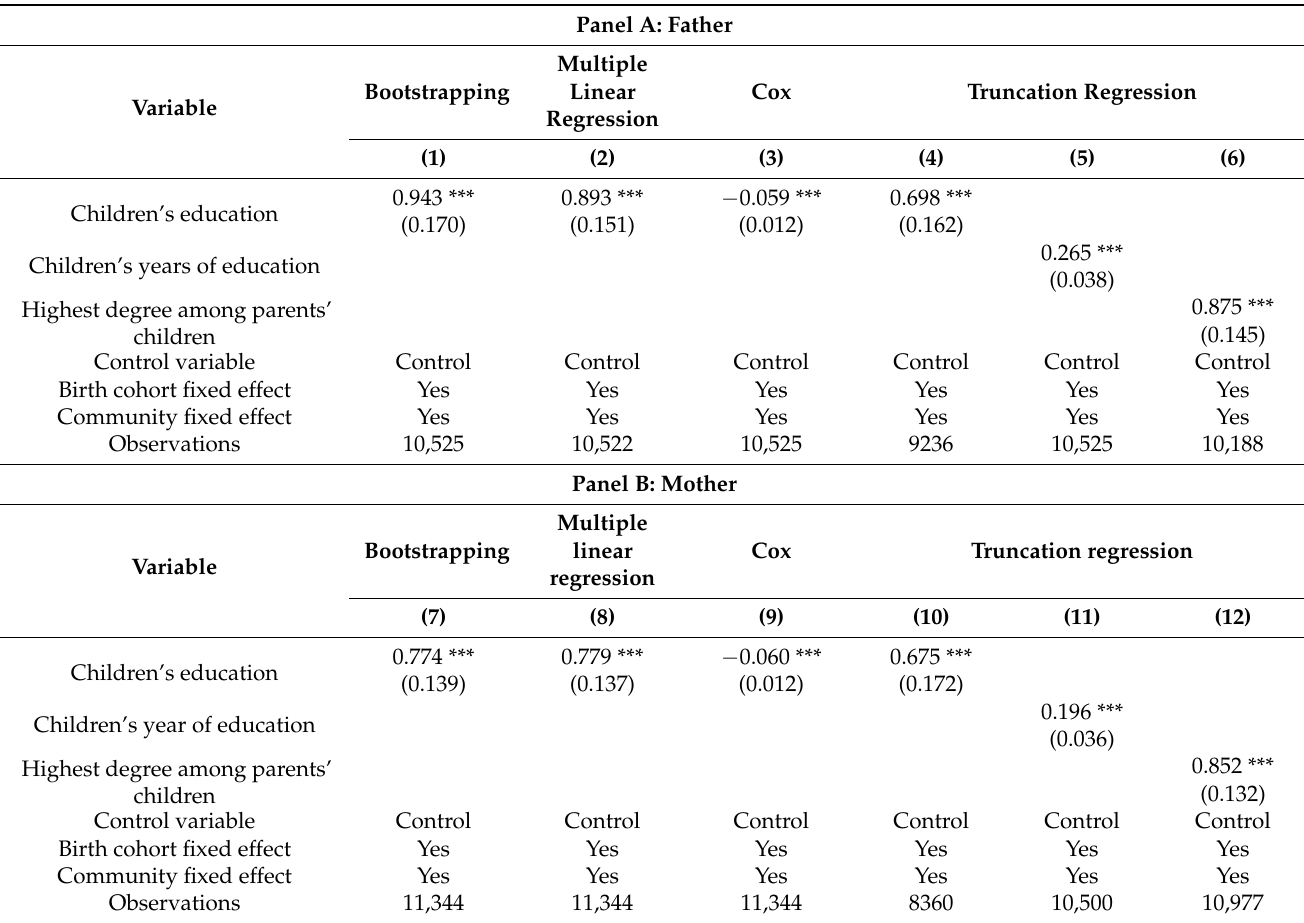
Table 5. Estimation results of the robustness tests. Panel A: